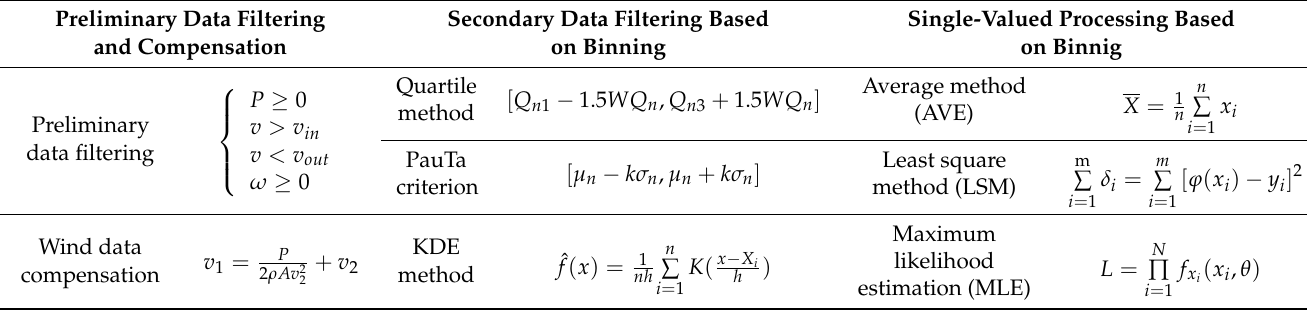
Table 1. Data pre-processing